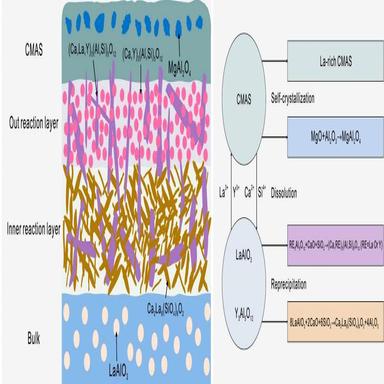
Schematic diagram of the corrosion resistance mechanism for (Y1-xLax)3Al5O12 (x = 0.1, 0.2, 0.3).